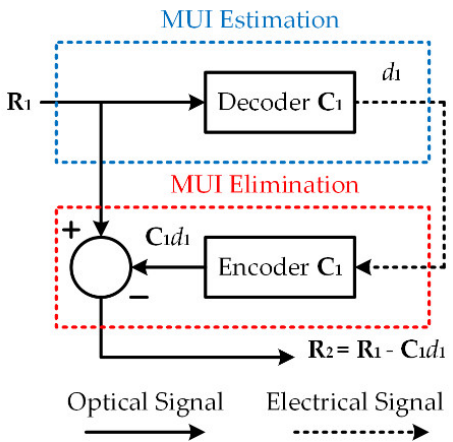
Figure 1. Relative phases of multiuser interference (MUI) estimation/elimination at the 1st stage of the proposed receiver.